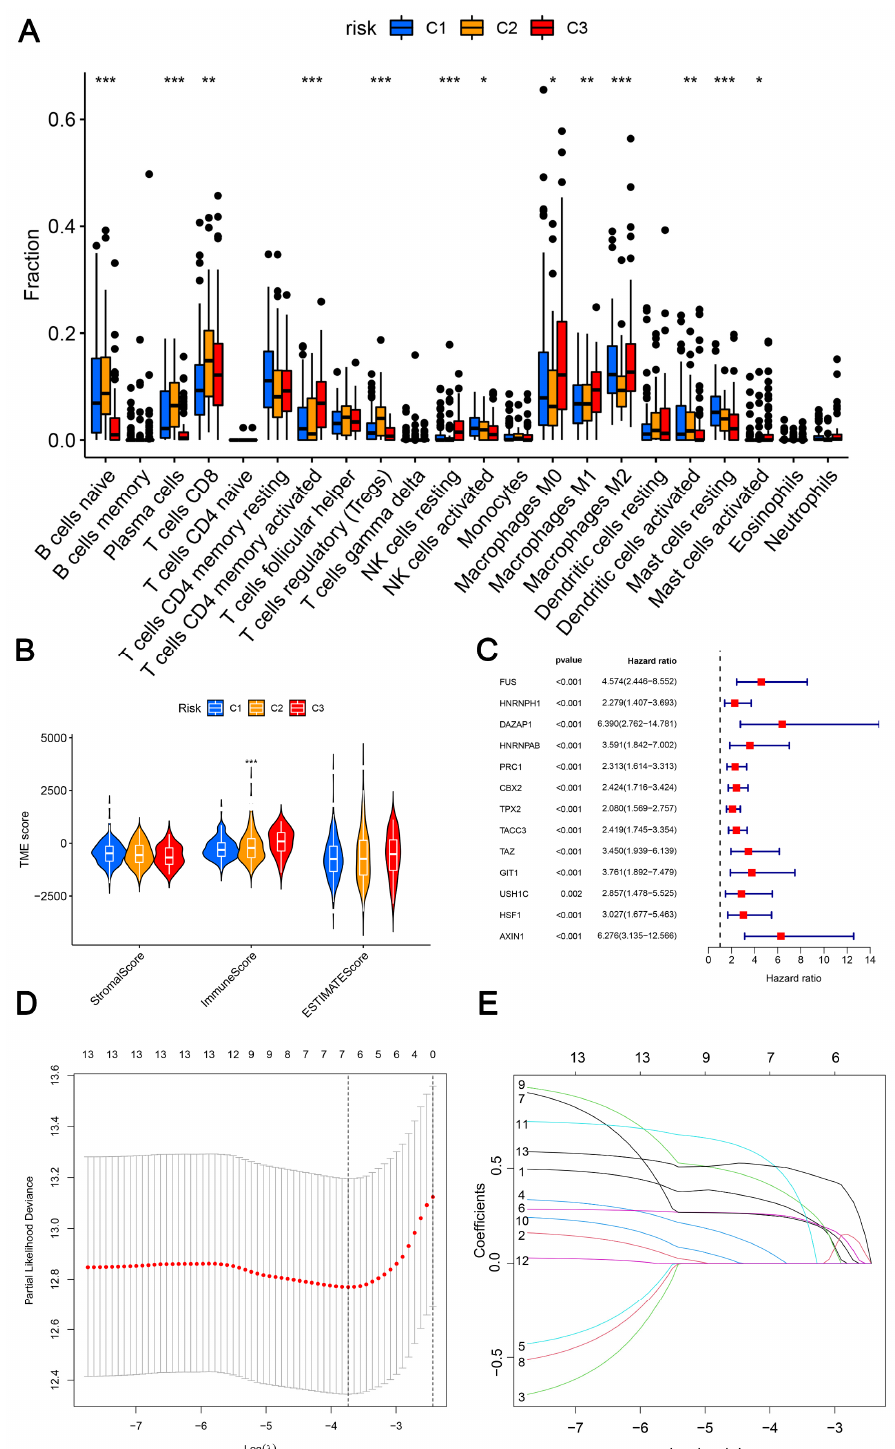
Figure 3. The correlation between three LLPS-related molecular clusters and immune cells infiltra- tion ( A ), as well as tumor microenvironment scores ( B ). Identification of 13 prognostic LLPS-related genes based on univariate Cox regression analyses ( C ). Optimal predictor (lambda) selection in the lasso model: Lasso coefficients and vertical dashed lines were calculated at the best log (lambda) value, the red dots represented the target parameters corresponding to each lambda ( D ). The LASSO Cox analysis of the optimal prognostic DELRGs, the coefficients of the selected features are shown via the lambda parameter ( E ). *: p < 0.05; **: p < 0.01; ***: p <